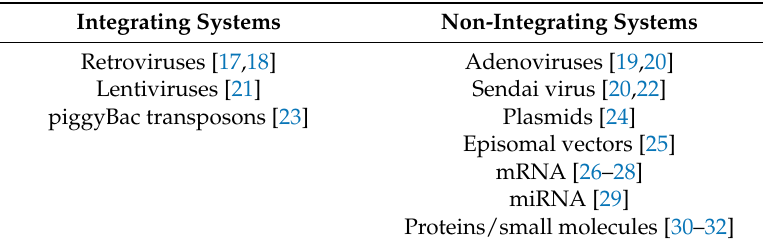
Table 1. Overview of current reprogramming